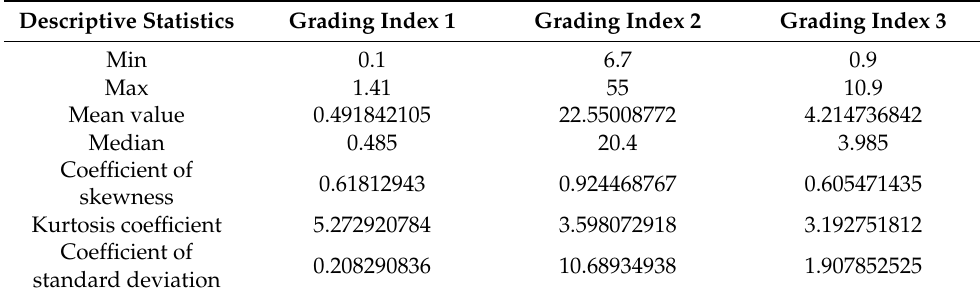
Table 5. Statistical parameters of hierarchical index fractal dimension data.